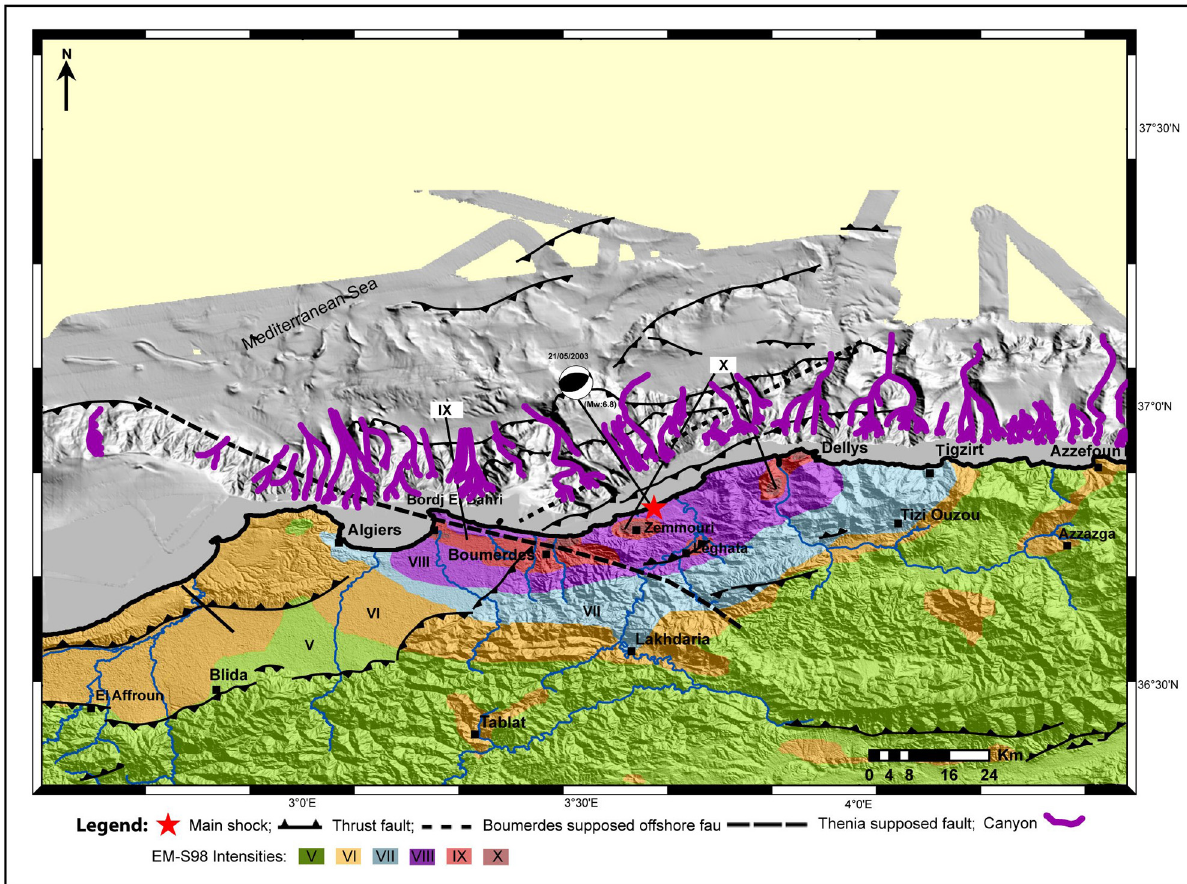
Figure 2. Seismotectonic map of Boumerdès and the surrounding area. Main shock [Bounif et al. 2004], focal mechanism [Delouis et al. 2004] and faults are from Meghraoui et al. [1988], Déverchère et al. [2005], Domzig et al. [2006], Ayadi at al. [2008], Strzerzynski et al. [2010]. The background is shaded topographic (90 m-SRTM DEM) map wrapped with the EMS-98 isoseismal map (from Harbi et al.